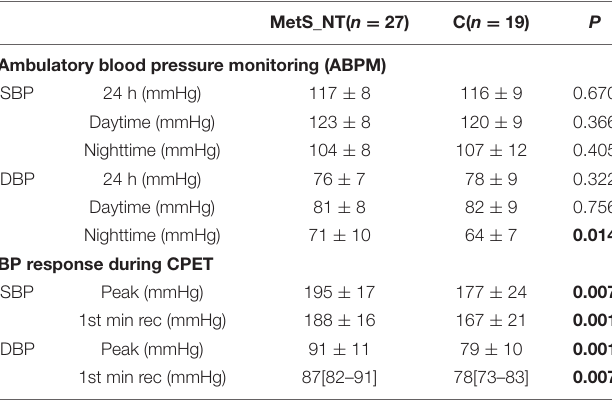
TABLE 2 | Ambulatory Blood Pressure Monitoring recordings (ABPM) and BP response during cardiopulmonary exercise test (CPET) in MetS_NT and in C group.